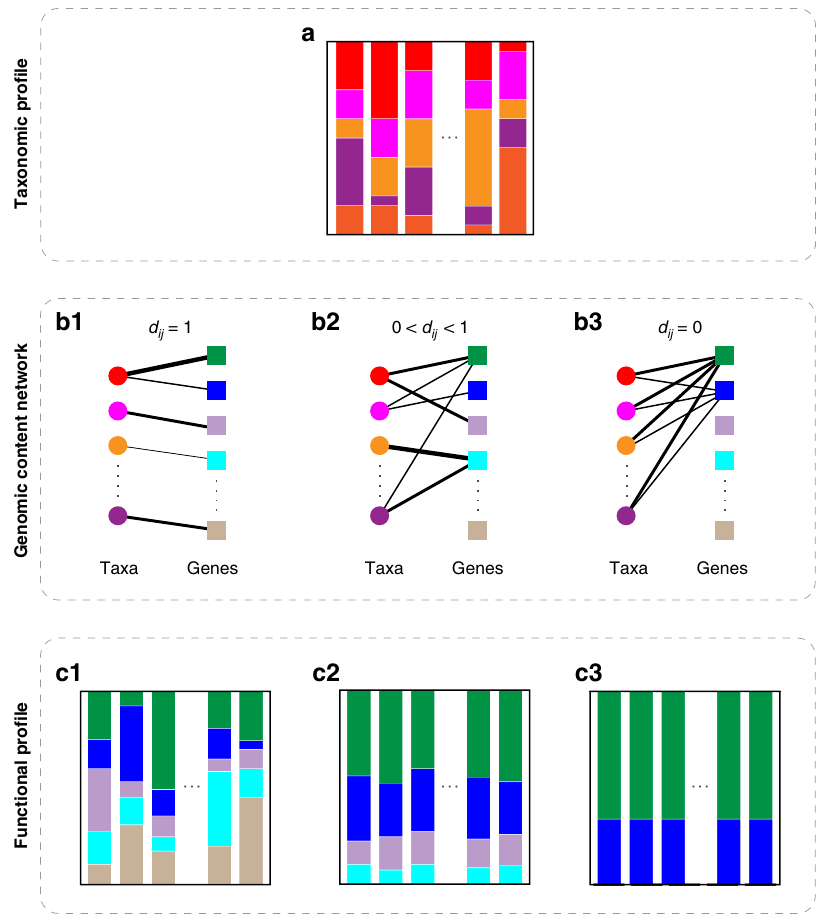
Fig. 1 Structure of the genomic content network is crucial for determining the functional redundancy and functional diversity of microbial communities. Here we use hypothetical examples to demonstrate this point. a The taxonomic pro fi les vary drastically across many local communities (i.e., microbiome samples from different individuals). b Genomic content networks are bipartite graphs that connect taxa to the genes in their genomes. The left-hand side nodes (circles) represent different taxa and the right-hand side nodes (squares) represent different genes. The edge weight represents the gene copy number. b-1 Each taxon has a unique genome. b-2 Different taxa share a few common genes, some taxa are specialized to have some unique genes. b-3 All taxa share exactly the same genome. c For each microbiome sample, its functional pro fi le can be calculated from its taxonomic pro fi le in a and the genomic content network in b . c-1 The functional pro fi les vary drastically across different microbiome samples. For each sample, the functional diversity is maximized while the functional redundancy is minimized. c-2 The functional pro fi les are highly conserved across different samples. The within- sample functional diversity and functional redundancy are comparable. c-3 The functional pro fi les are exactly the same across all different microbiome samples. For each sample, the functional diversity is minimized while the functional redundancy is